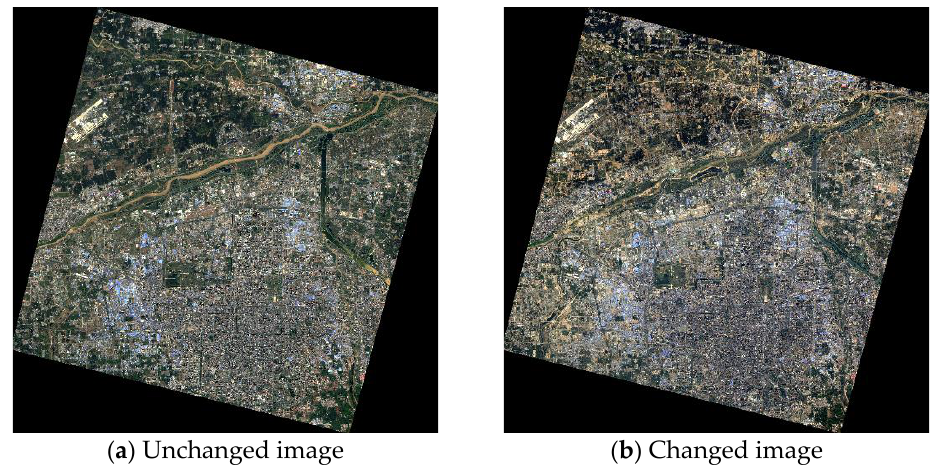
Figure 1. Bi-temporal images: ( a ) 2015 Xi ’ an GF1 image and ( b ) 2017 Xi ’ an GF1 image. We visually interpreted the remote sensing images of Xi ’ an in 2015 and 2017 to obtain the changed label as shown in Figure 2, where the white color indicates the changed areas and the black color indicates the unchanged areas.